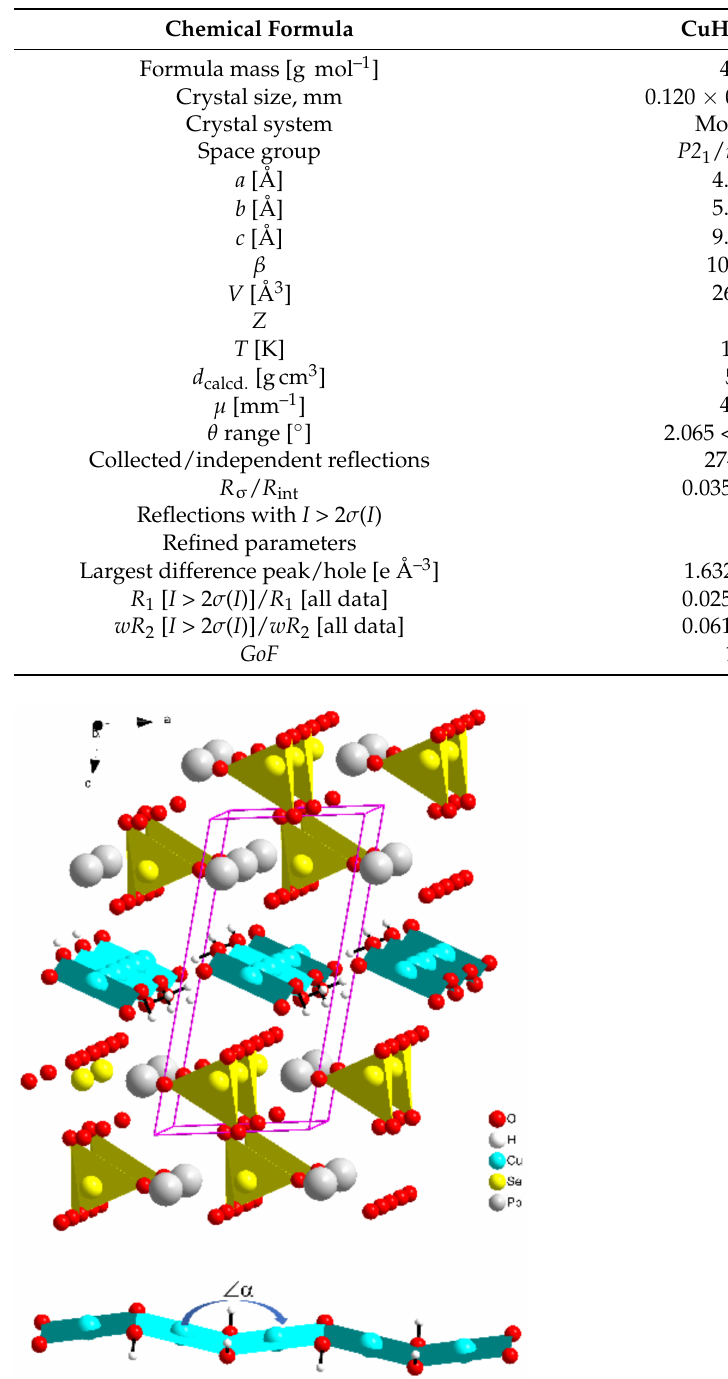
Table 2. CuO 4 squares share their O4-O5 edges and form zig-zag chains along the